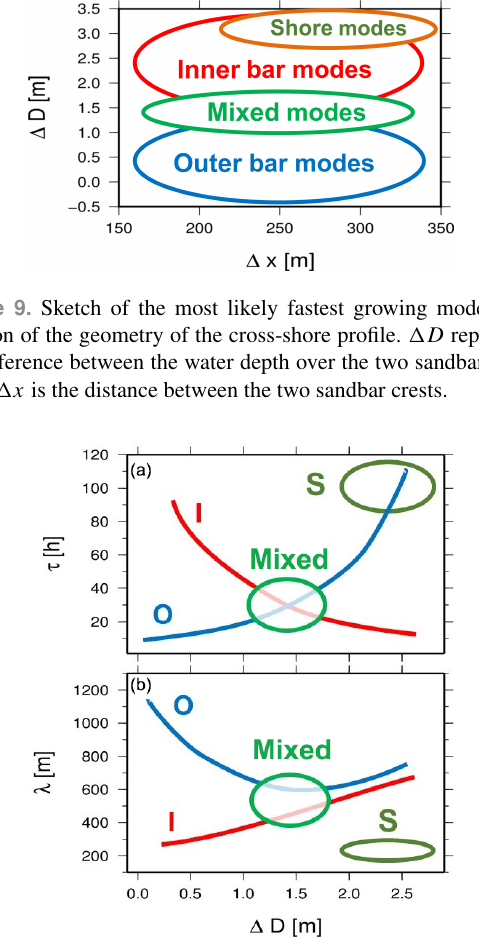
Figure 10. Sketch that summarizes our findings in terms of (a) growth time and (b) crescentic sandbar spacings. The colours refer to the modes in Fig.